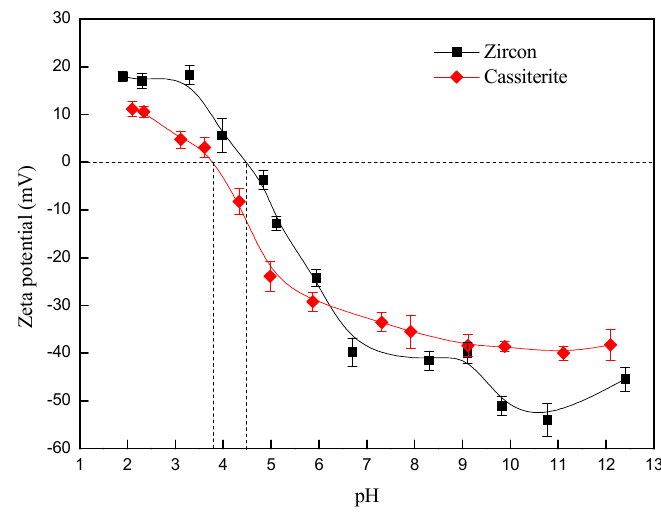
Figure 11. Zeta potentials of zircon and cassiterite as a function of pH.